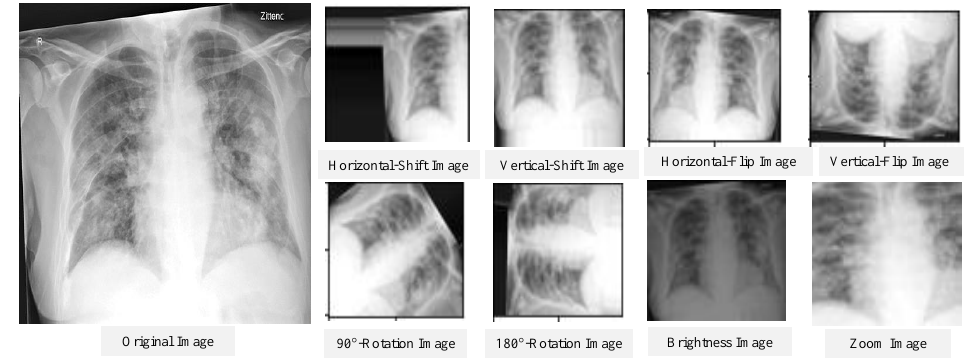
Figure 1. Results of the data augmentation procedure on a certain CXR image.